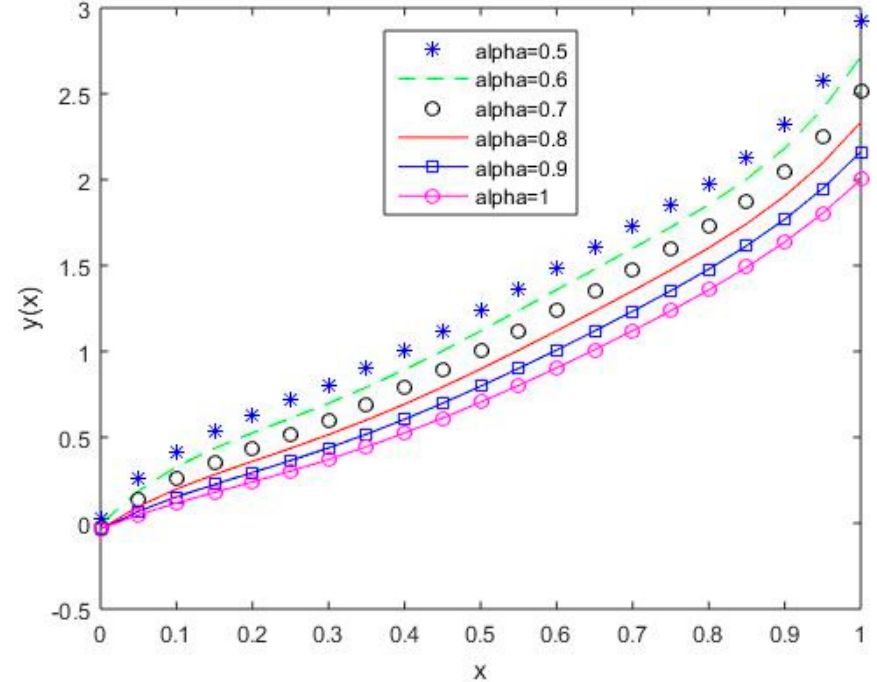
Figure 20. The behavior of solutions using S5 for 𝛼 values of 0.5, 0.6,0.7, 0.8, 0.9, and 1 , Example 2.